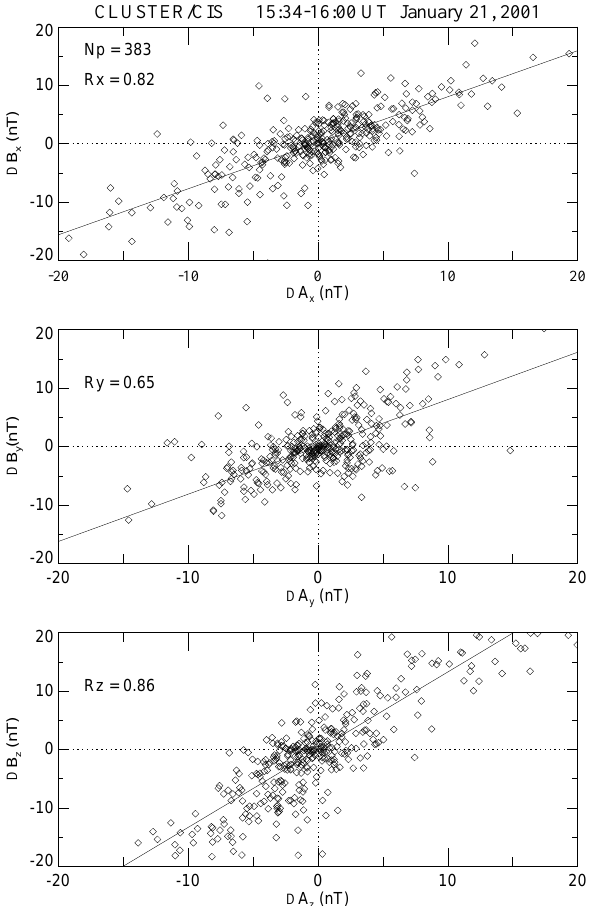
Fig. 7. The relation between the field and flow disturbances. A line of unit gradient passing through the origin would indicate perfect agreement with the Alfv´enic relation under the simplification of a proton plasma and temperature isotropy. Approximate agreement with this is registered in all components. The correlation coeffi- cients are shown in each panel.